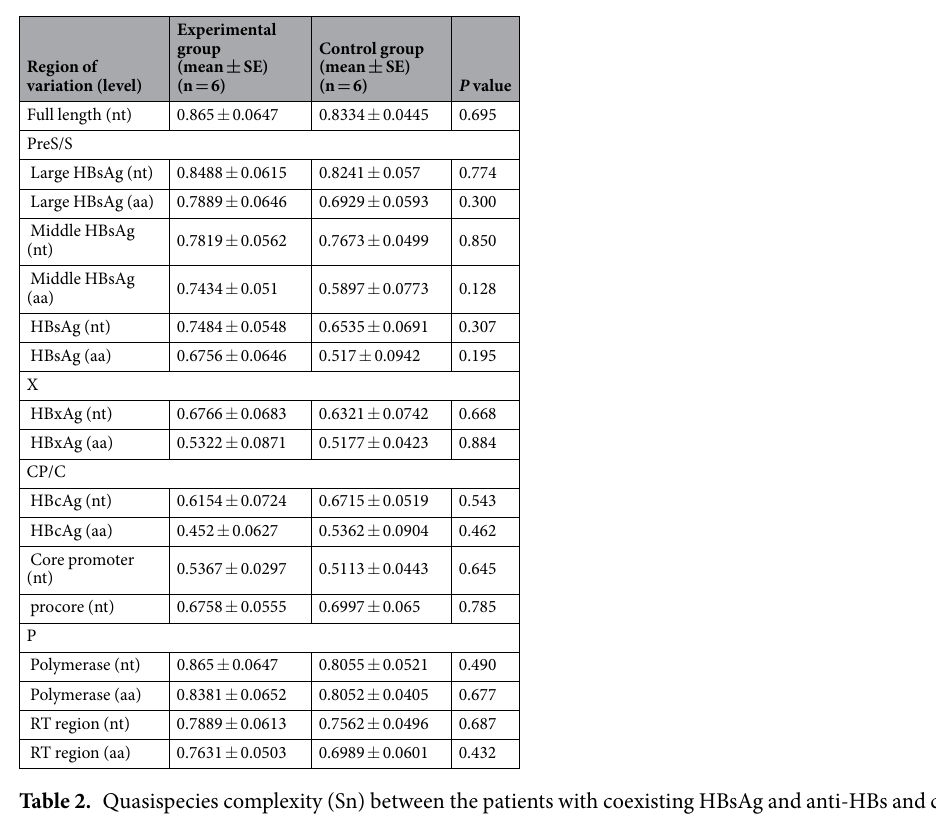
and control groups (Table 3). The experimental group had a significantly higher mean genetic distance (d) and Dn in the LHBsAg, MHBsAg, and HBsAg ( p < 0.05) at the nucleotide and amino acid levels. All other genes were statistically similar among the groups. The complexity of nucleotide positions varied among the three HBV genome genotypes (Fig. 2). Among the three genotypes, the control groups typically had fewer mutations than the experimental groups, while an excep- tional number of mutations were found in the genes encoding LHBsAg, MHBsAg, and HBsAg in genotype C ( p < 0.001, Supplementary Table 1), which located in HLA I T cell epitopes or multiple types epitopes (Fig. 2 and Supplementary Table 2).